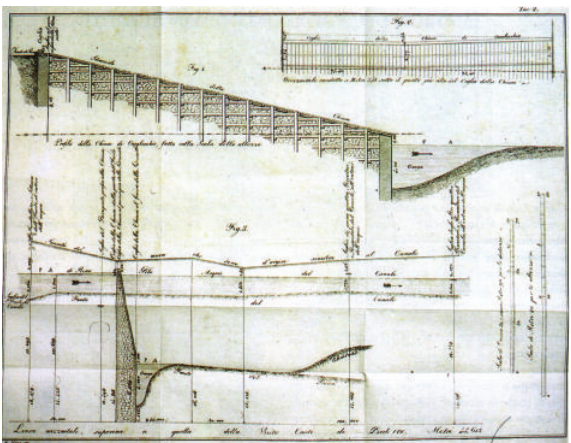
Figure 3: Sections of the Casalecchio di Reno by Antonio Lecchi,